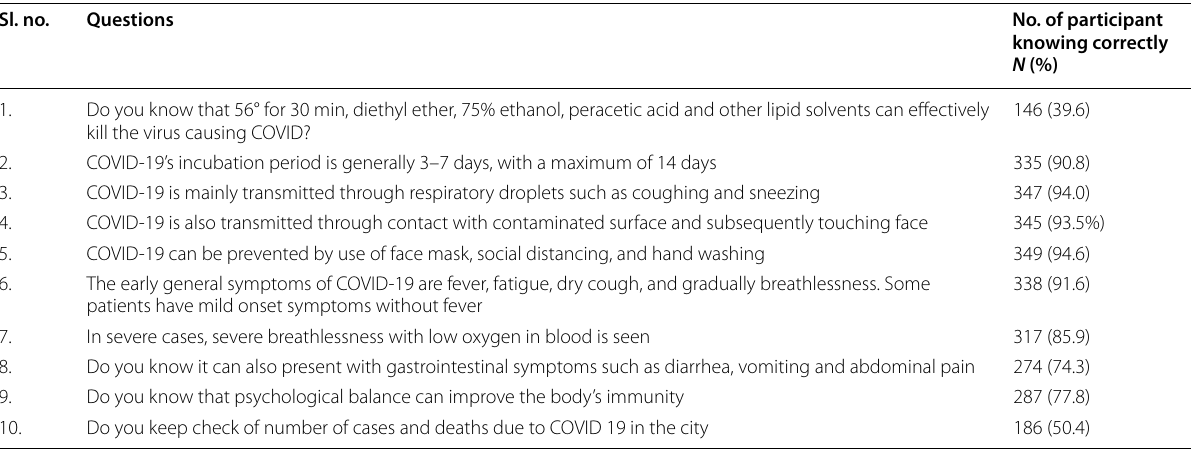
As per DASS-21 scores of the participants, 190 (48.6%) were found to have depression, 214 (54.7%) were found to have anxiety and 179 (45.8%) were found to have stress. The classification of these participants into mild, moderate, severe, and very severe categories is shown in Table 3